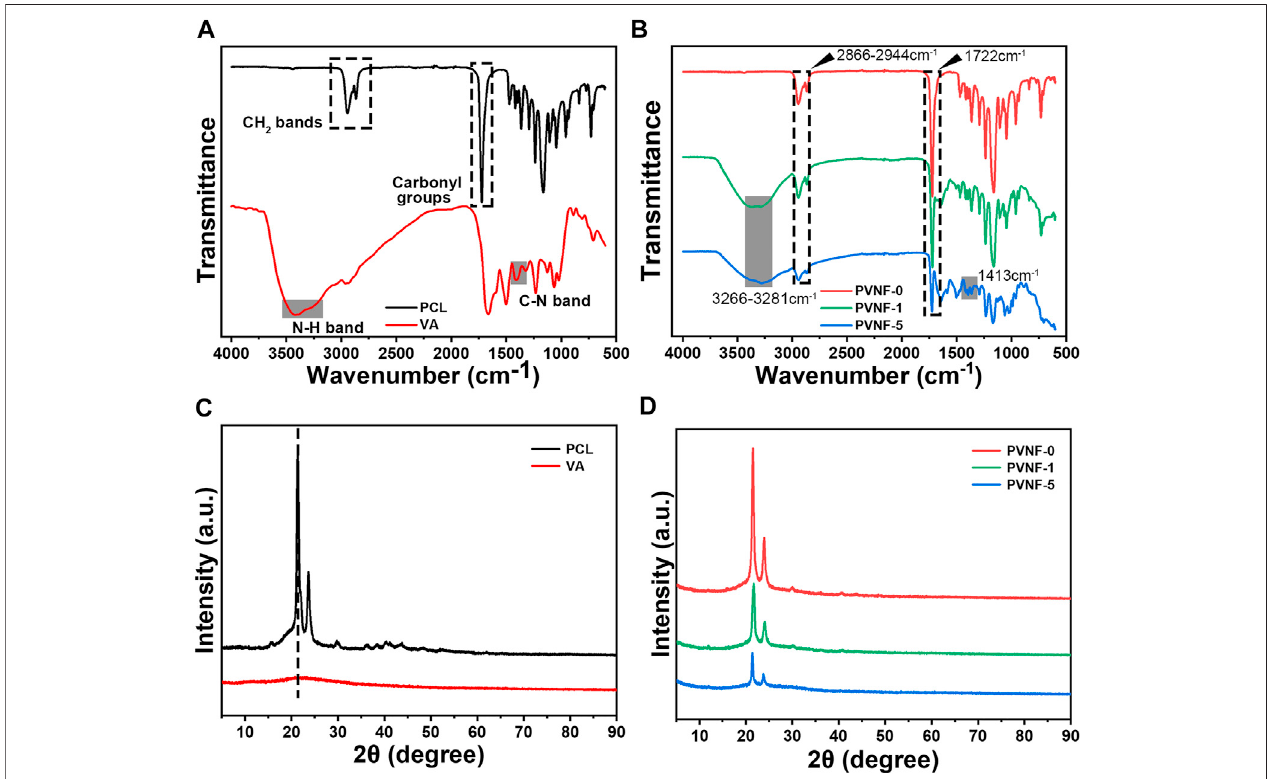
FIGURE2|(A) FT-IRspectraofthepolycaprolactone(PCL)andvancomycin(VA)rawmaterials. (B) FT-IRspectraofPVNF-n( n (cid:1) 0,1,and5,respectively). (C) XRD spectra of the PCL and VA raw materials. (D) XRD spectra of